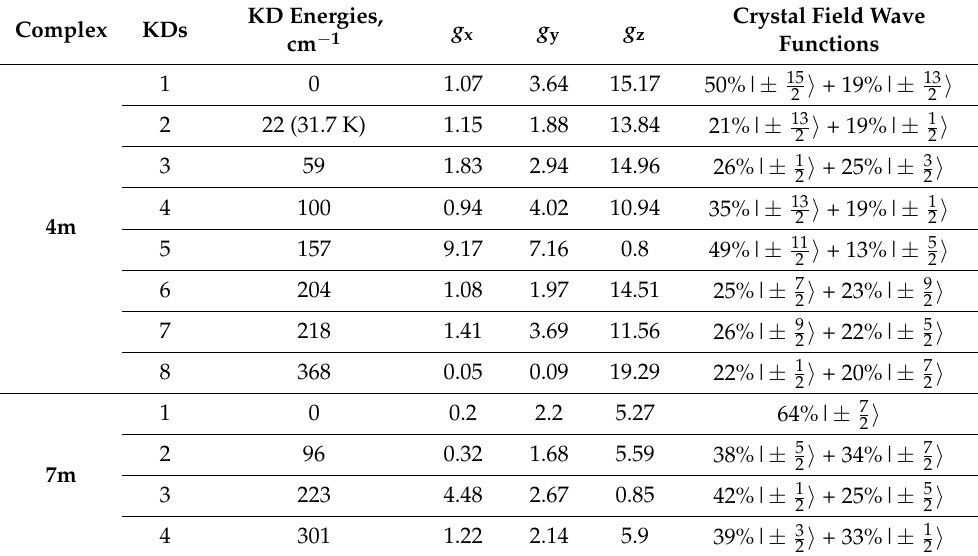
Table 3. Calculated at the SA-CASSCF/SO-RASSI level energies, corresponding g-tensors, and crystal field wave functions for Kramers doublets (KDs) of the ground state multiplets: the 6 H 15/2 of Dy III in 4m and 2 F 7/2 of Yb III in 7m